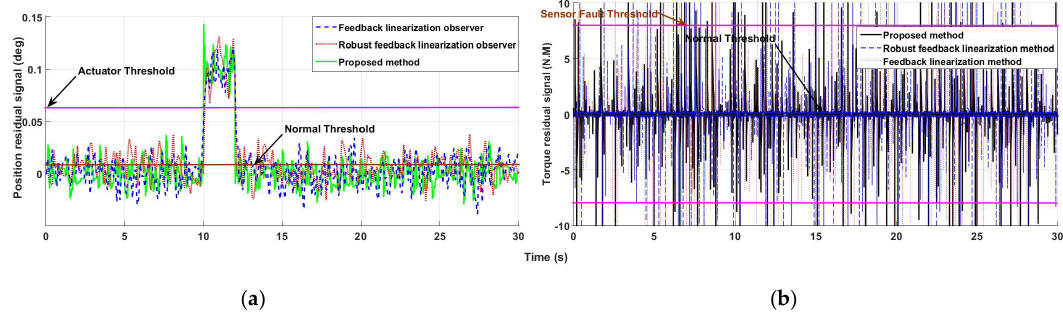
Figure 17. ( a ) Position residual signals and ( b ) torque residual signals for actuator-sensor